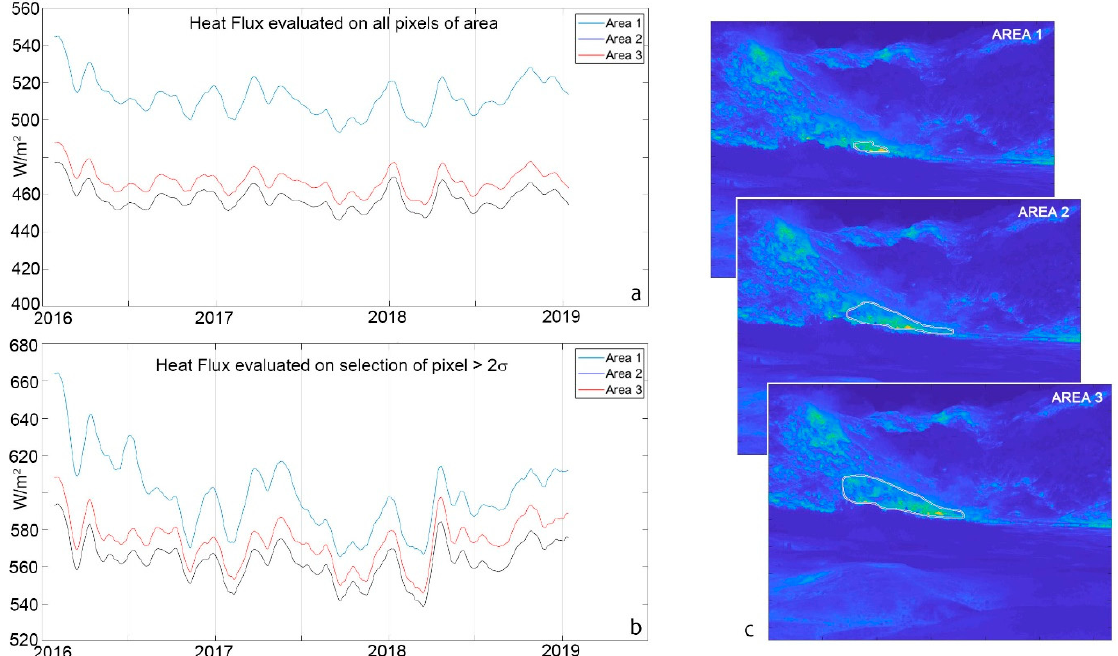
Figure 11. Heat flux plots of selected areas inside SF1 frames. Area 1 (c) includes the mayor thermal anomaly, Area 2 and 3 (c) include emission-free rocks. Plot a) = heat flux trends (smoothed with window = 29) of Areas 1, 2 and 3 evaluated by selecting all the pixels inside each area. Plot b) = heat flux trends (smoothed with window = 29) of Areas 1, 2 and 3 evaluated by applying the selection of pixels greater than 2 s of temperatures frequency distribution.